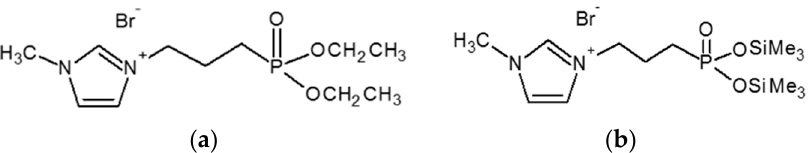
Figure 1. Representation of the structures of ImPE (1-methyl-3–(3–(diethylphosphinyl)propyl)- imidazolium bromide) ( a ) and ImTMSP (1-methyl-3–(3–((trimethoxysilyl)phosphinyl)propyl)- imidazolium bromide) ( b ).